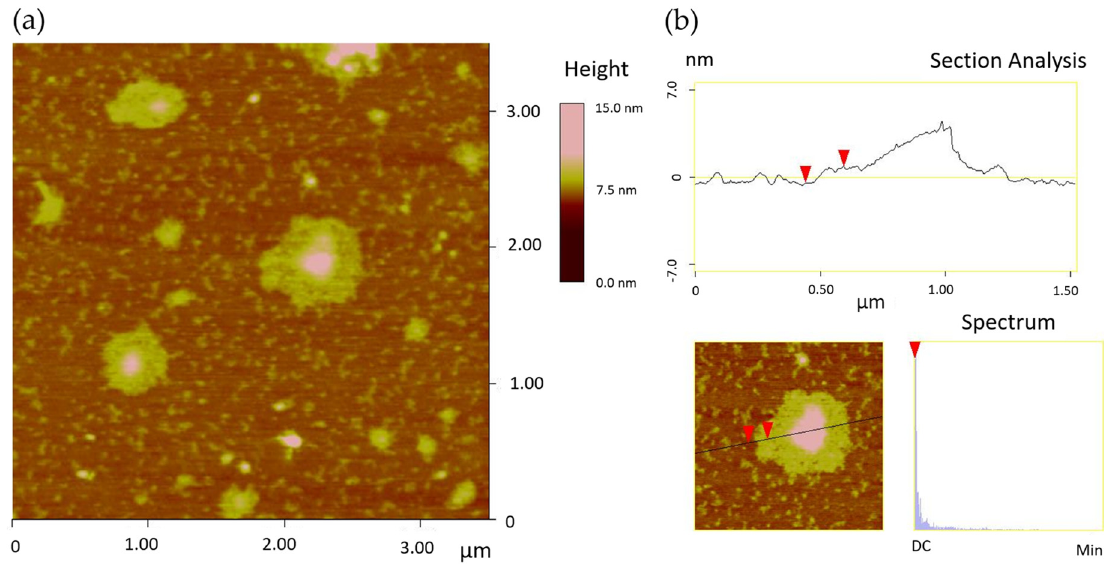
Figure 7. ( a ) AFM micrograph of g-POCN and ( b ) thickness analysis for a sheet of